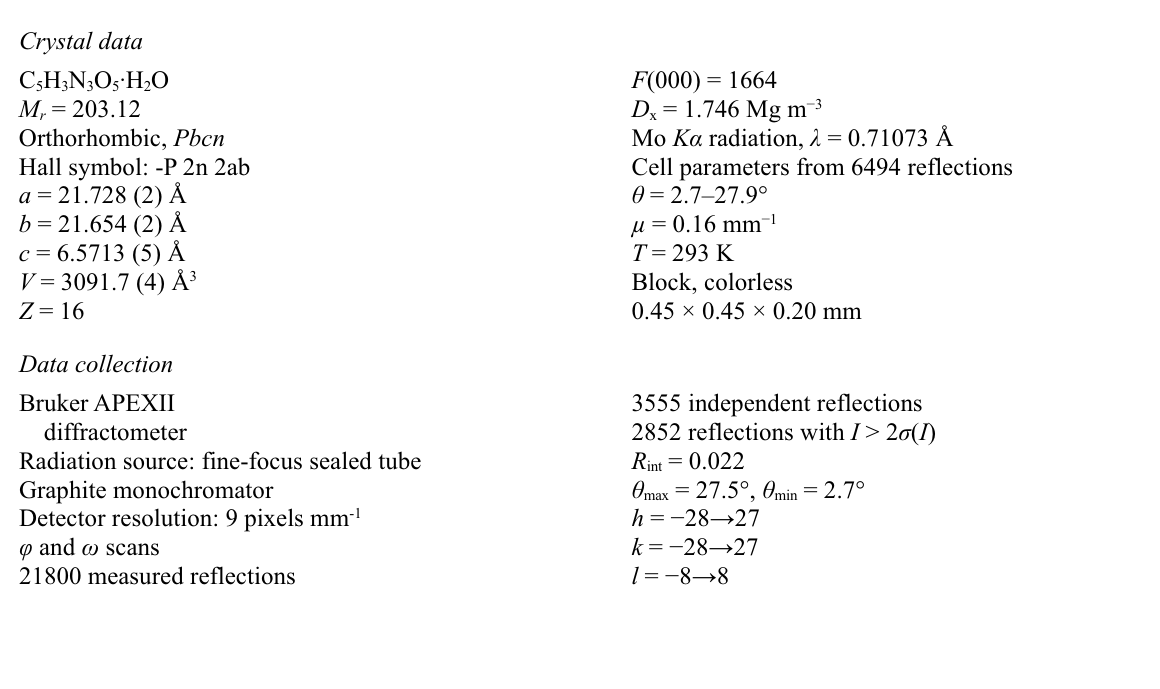
H N O 5. H O at the 50% probability 5 3 3 2